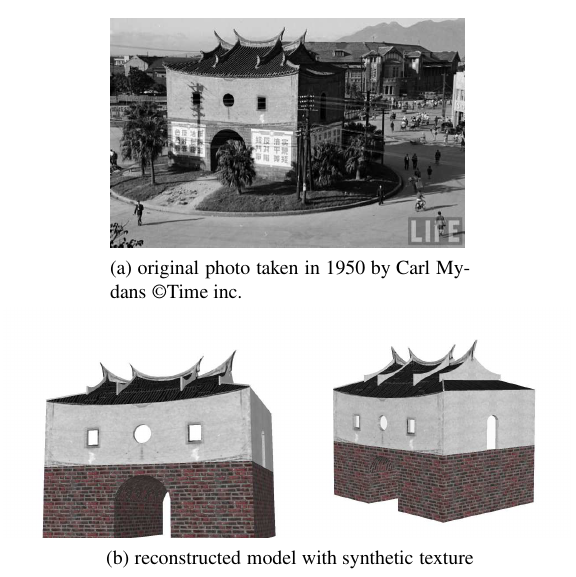
Figure 6: 3D reconstruction of Taipei North Gate from an old